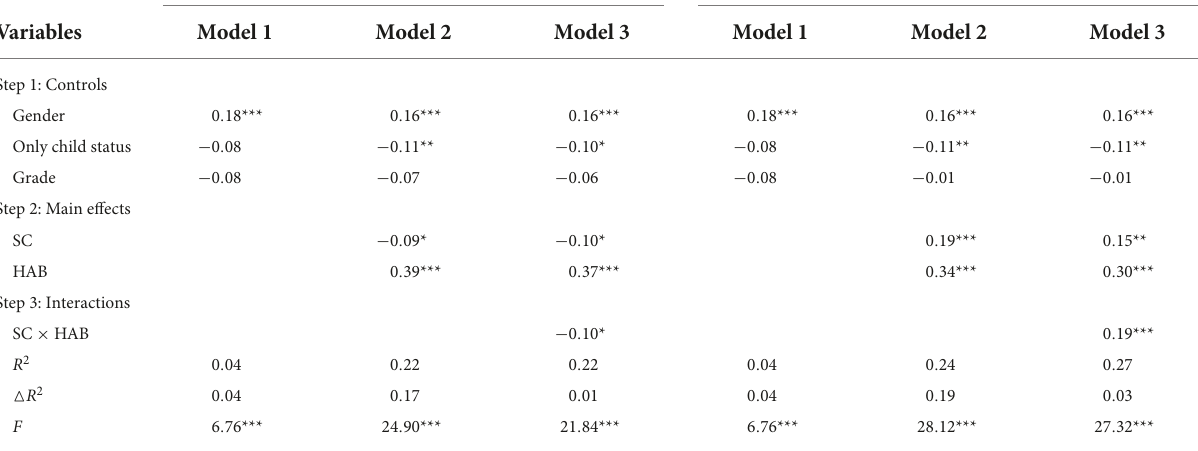
TABLE 3 Hierarchical regression analyses to assess the effect of hostile attribution bias on the relationships between appropriateness/harmfulness and aggressive behavior.